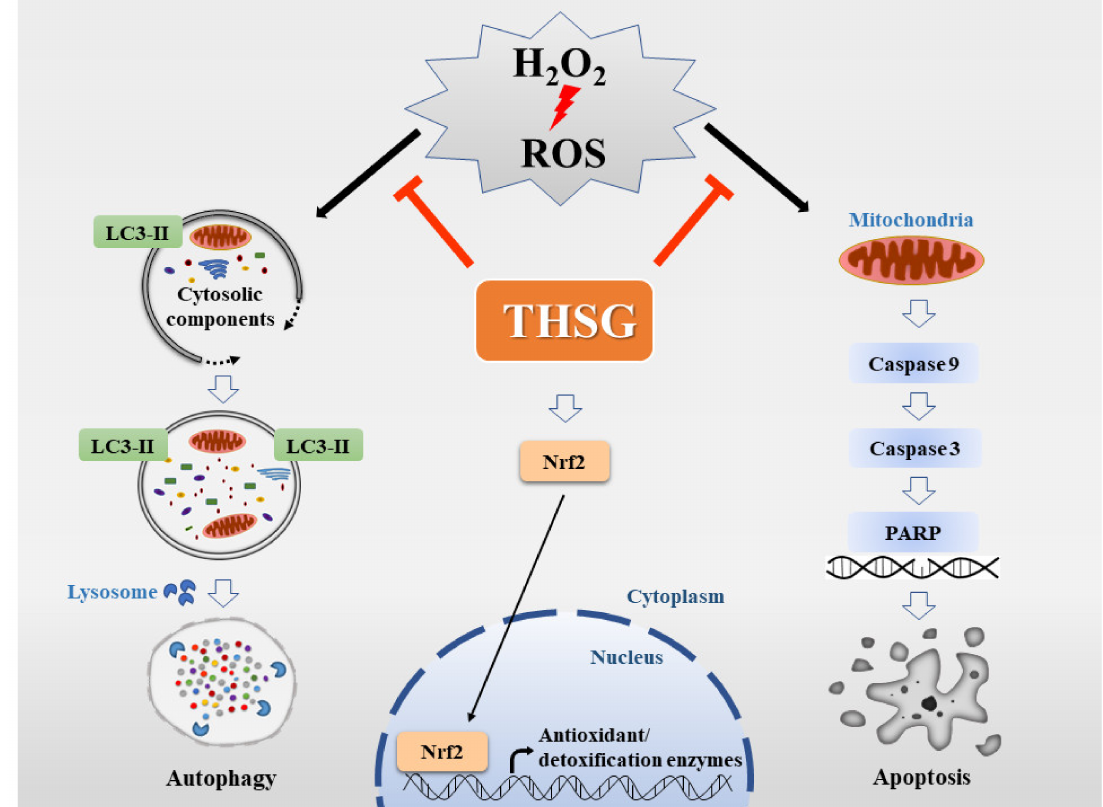
Figure 7. Schematic representation of the possible e ff ect of THSG on the Nrf2 antioxidant pathway and oxidative stress-induced cell death. THSG confers protection against H 2 O 2 -treated mouse cochlear UB / OC-2 cells by upregulating the Nrf2 antioxidant pathway and downregulating autophagy and